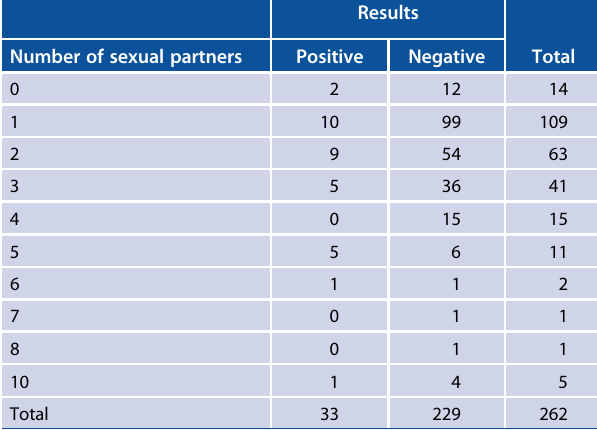
Table 3: Number of sexual partners according to HBV status